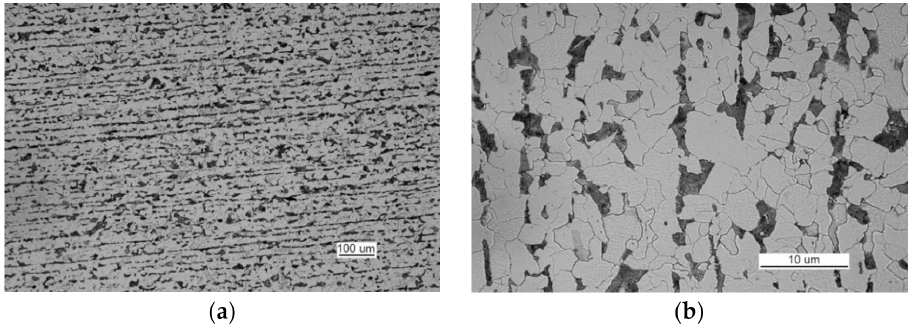
Figure 23. Optical microscopy views (handy-size bulk carrier 30206 DWT): ( a ) the ferritic and pearlitic structure of the steel of part II and ( b ) structure of the steel of part II (the cementite network is intermittent at the grain